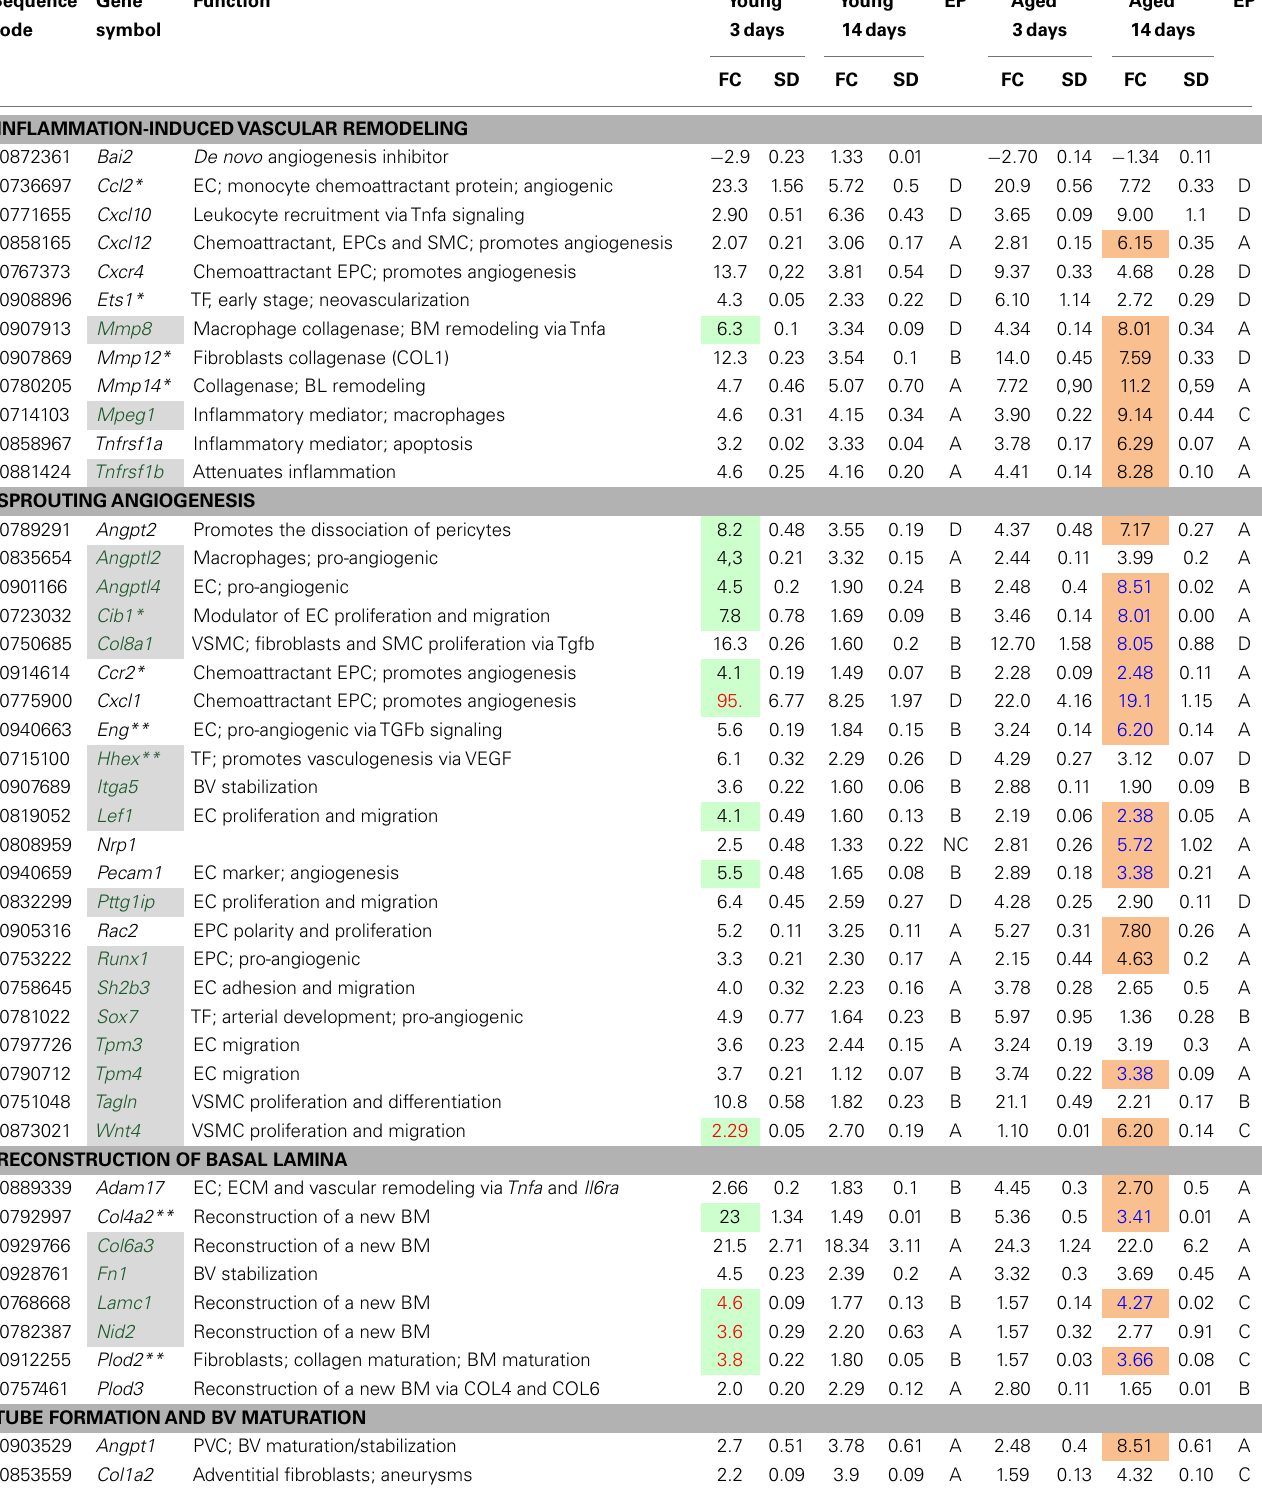
Table 2 | New or age-related angiogenesis and vascular remodeling-related genes after stroke verified by RT-PCR. Sequence